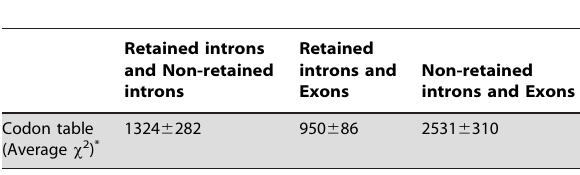
Table 4. Codon usage comparison of retained introns, exons and non-retained introns in human AS-NMD candidates.